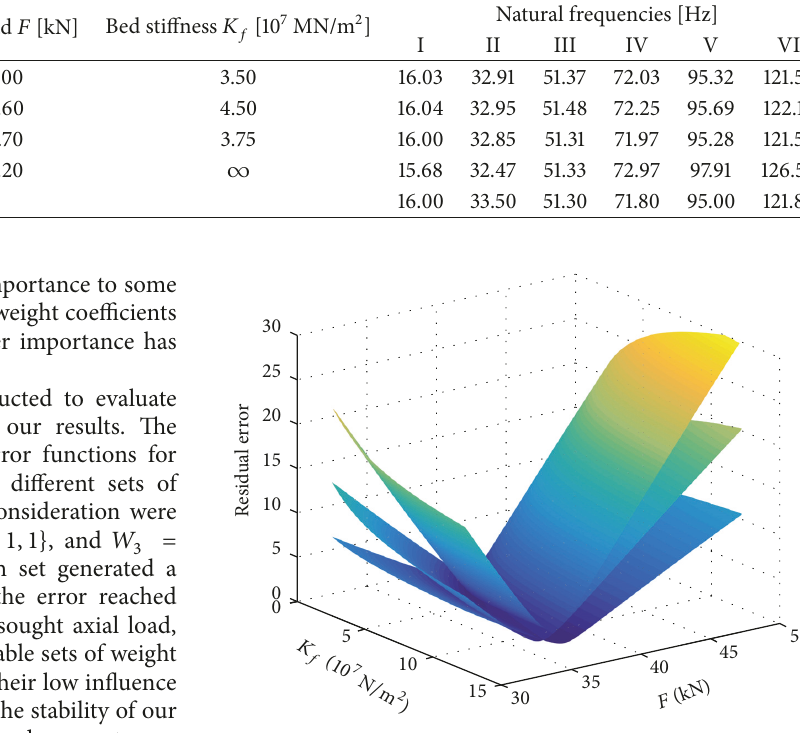
Figure 9: Residual error functions for sets of weight coefficients 𝑊 1 , 𝑊 𝑊 2 , 3